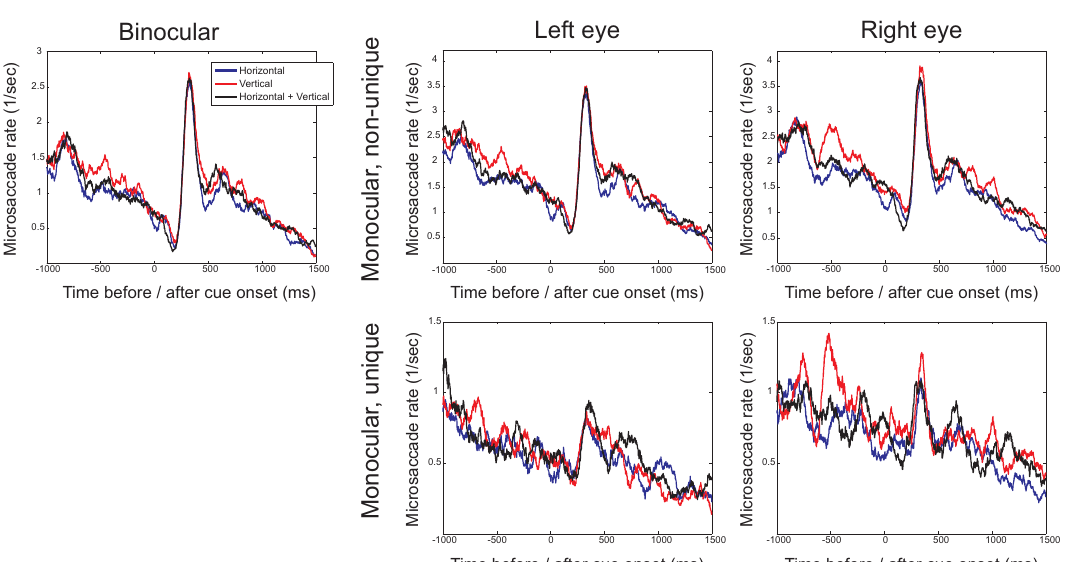
vertical). Separate plots show binocular microsaccades (left) and monocular microsaccades (right). Monocular rates are